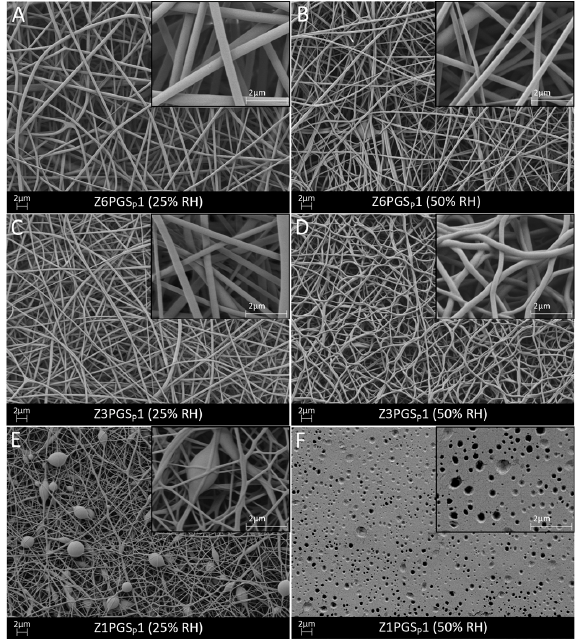
Figure 3. SEM micrographs of zein-PGS fibers: Z6PGS P 1 ( A , B ), Z3PGS P 1 ( C , D ) and Z1PGS P 1 ( E , F ) at 25% and 50% relative humidity. The fibers are shown at 5000× magnification and at 20,000× magnification in the inserts.